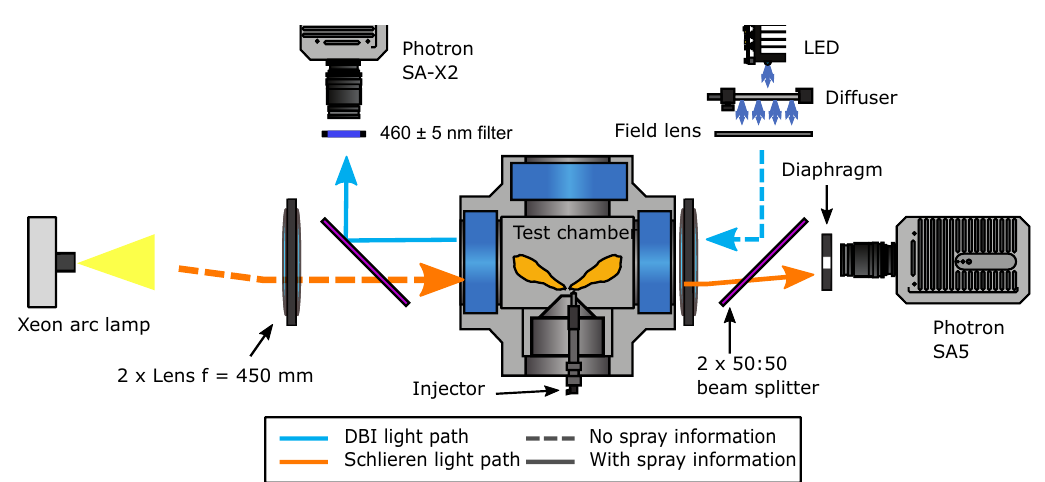
Figure 3. Schematic representation of the optical configuration used for the reactive spray